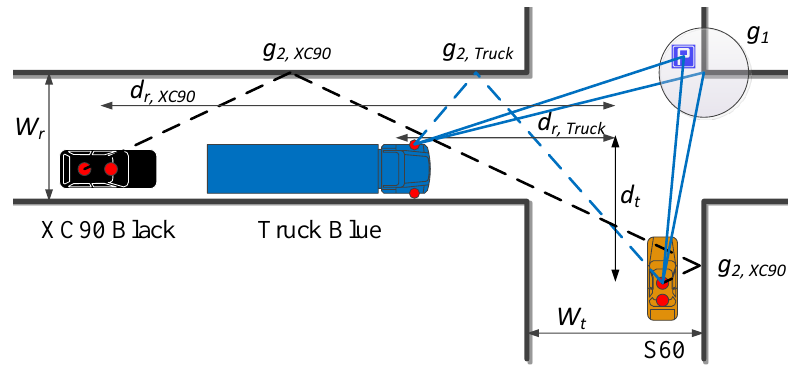
Figure 4. Description of the channel gain model for a typical non line-of-sight (NLOS) communication link between vehicles in an urban intersection. The solid blue lines represent single interactions from the center area of the intersection which are only “seen” by Truck Blue and the S60. The XC90 Black is blocked by Truck Blue and has OLOS towards the intersection center; therefore, it has no single interactions towards the S60. Dashed lines represent multiple interactions between the S60 and Truck Blue and between the S60 and XC90 Black, respectively.